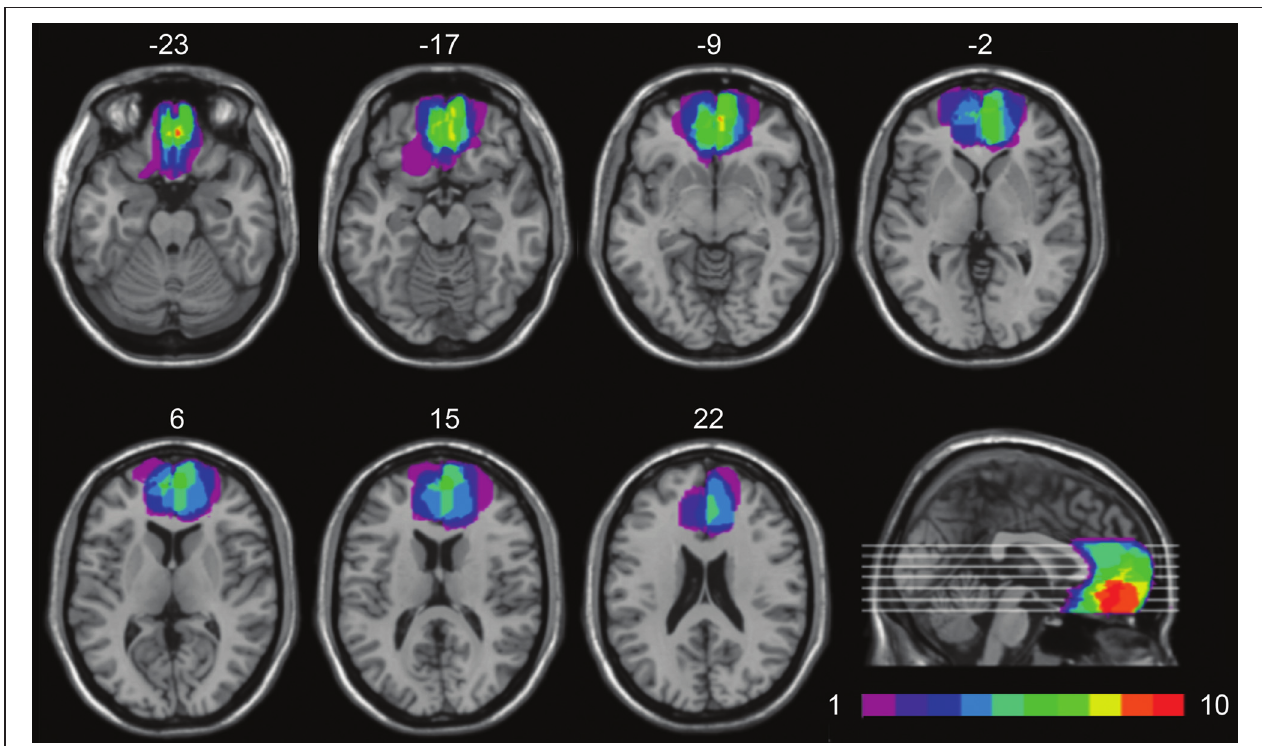
horizontal lines on the mesial view of the brain. z-coordinates of each axial slice are given. The color bar indicates the number of overlapping lesions. In each axial slice, the left hemisphere is on the left